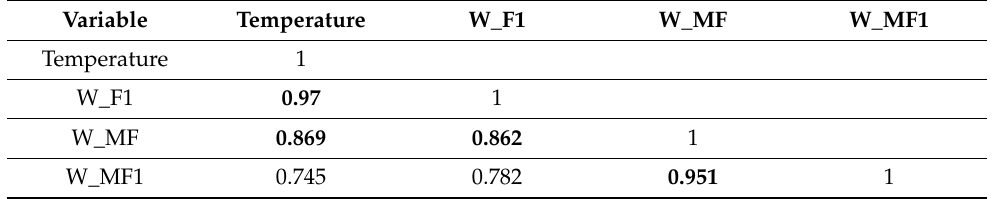
Table 4. Correlation matrix of